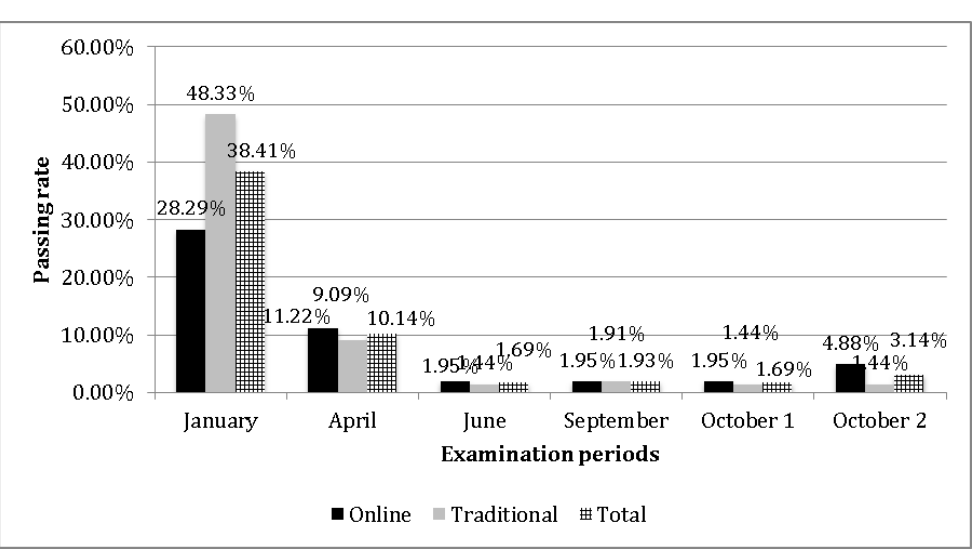
Figure 3 . Passing rates compared at different examination